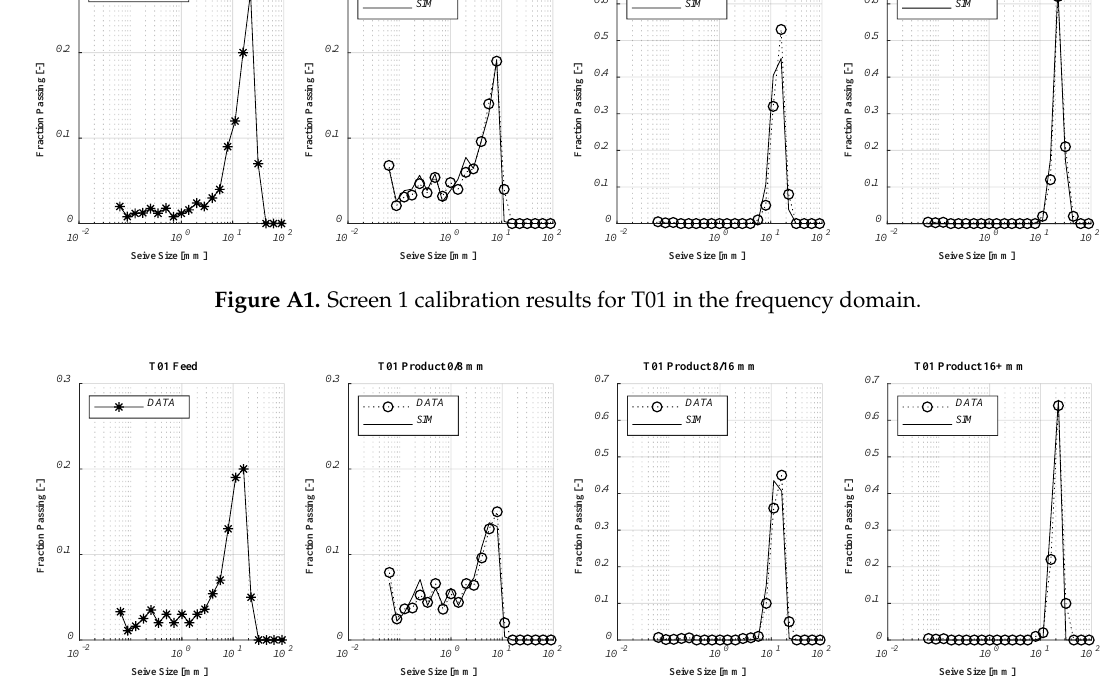
Figure A3. Screen 2 calibration results for T01 in the frequency domain.